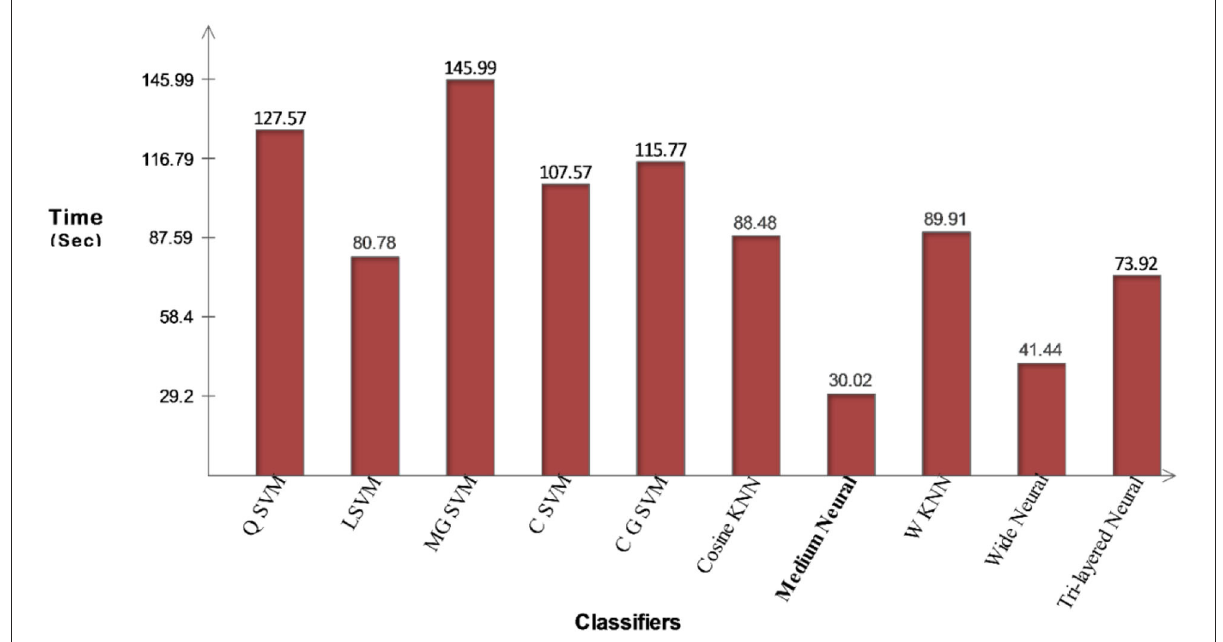
FIGURE15 Illustration of computational time for chest X-ray dataset using the proposed fusion method.